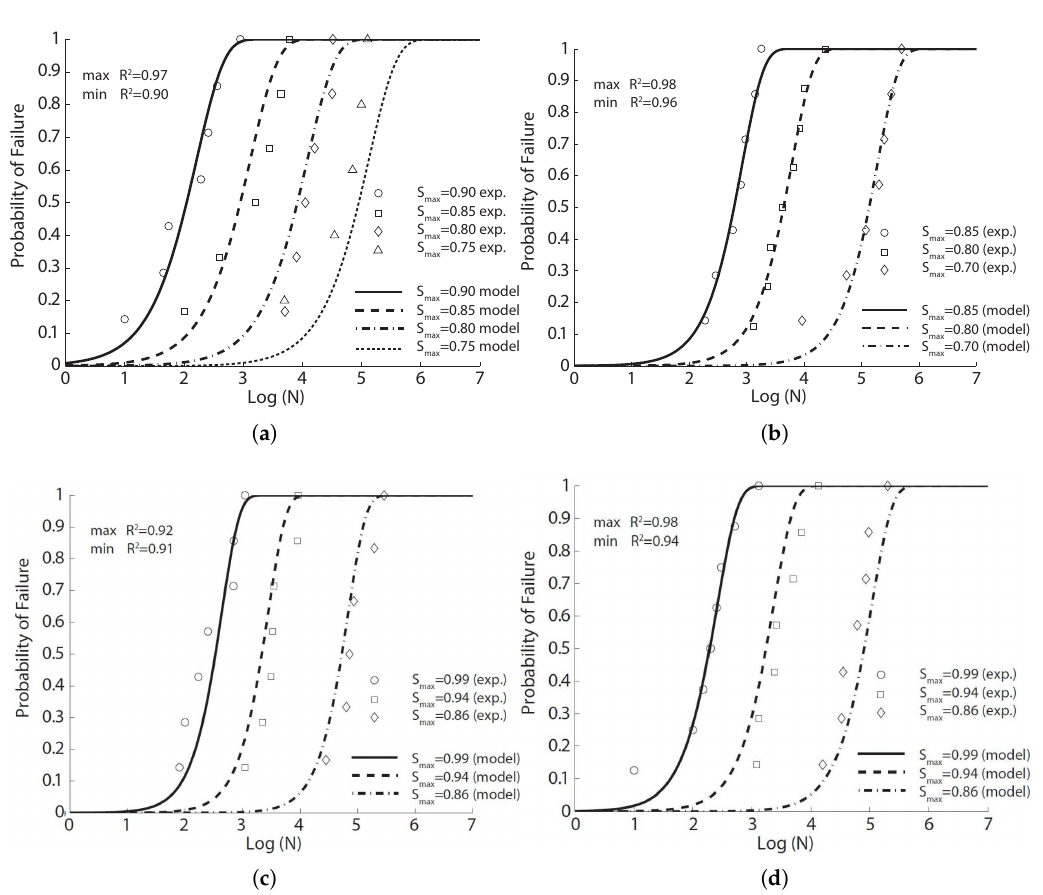
Figure 3 for the same fiber volume ratio (1.0%) using the same set of model parameters listed in Table 5. It is noteworthy that the correlation coefficients surpass 0.90 for the same types of fibers. This coefficient decreases significantly when the fibers are distinct. This indicates that for the same amount of fiber content, even though the flexural strength may not greatly vary, the fatigue life may vary significantly depending on the type of steel fibers.